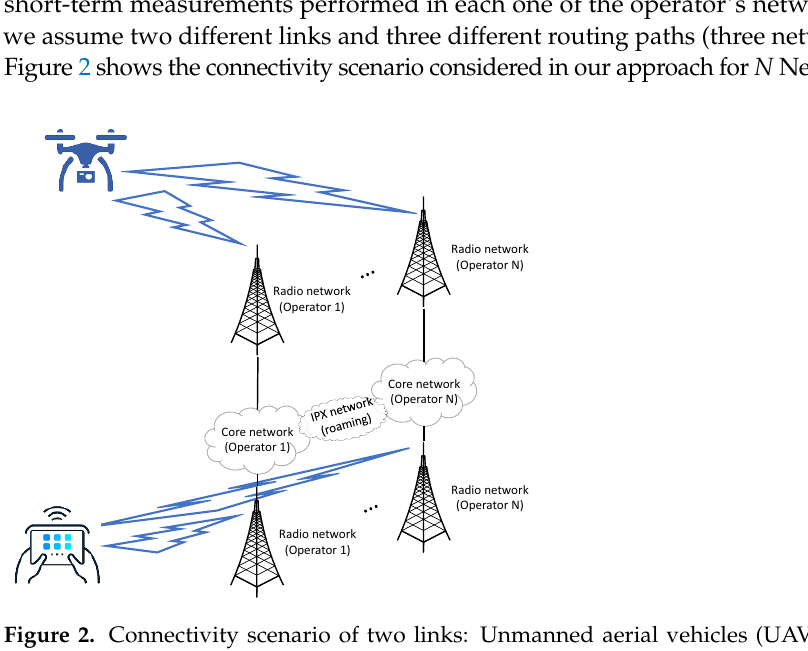
Figure 1. Delay measurements in communication between drone and control station.